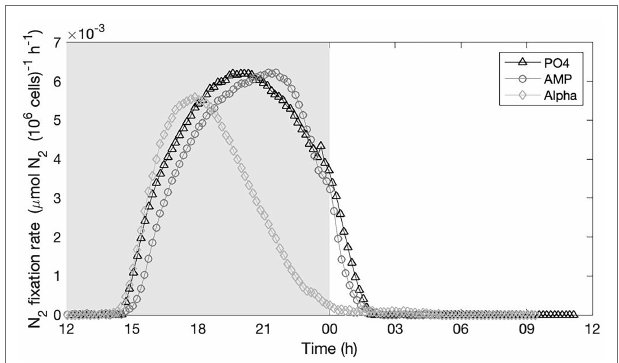
FIGURE 4 | Nitrogenase activity monitored on-line in cultures provided with either an inorganic (PO 4 ; triangles) or organic [mono phosphate adenosin (AMP; circles) or DL- α -glycerophosphate (Alpha; diamonds)] source of phosphorus for growth. The grey, shaded area represents the dark